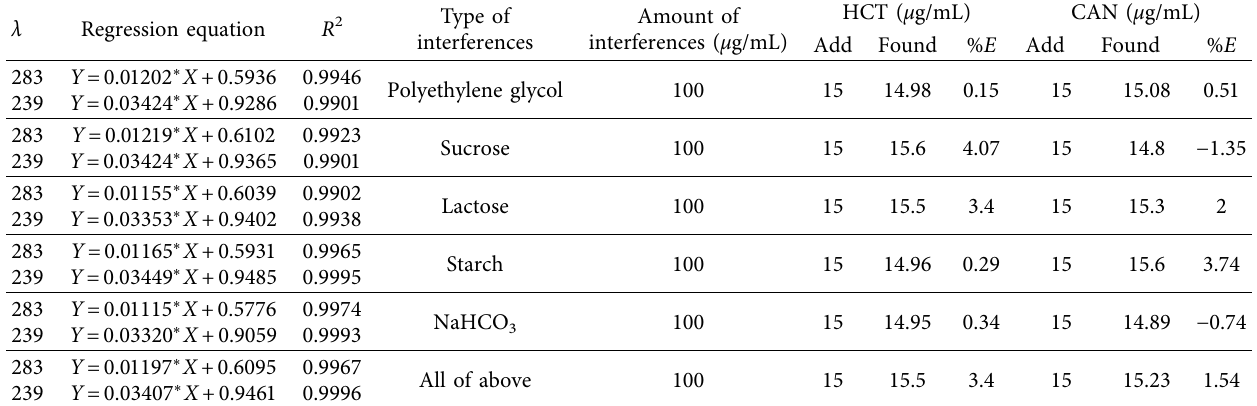
Table 13: Efect of interferences on the H -point standard addition method.